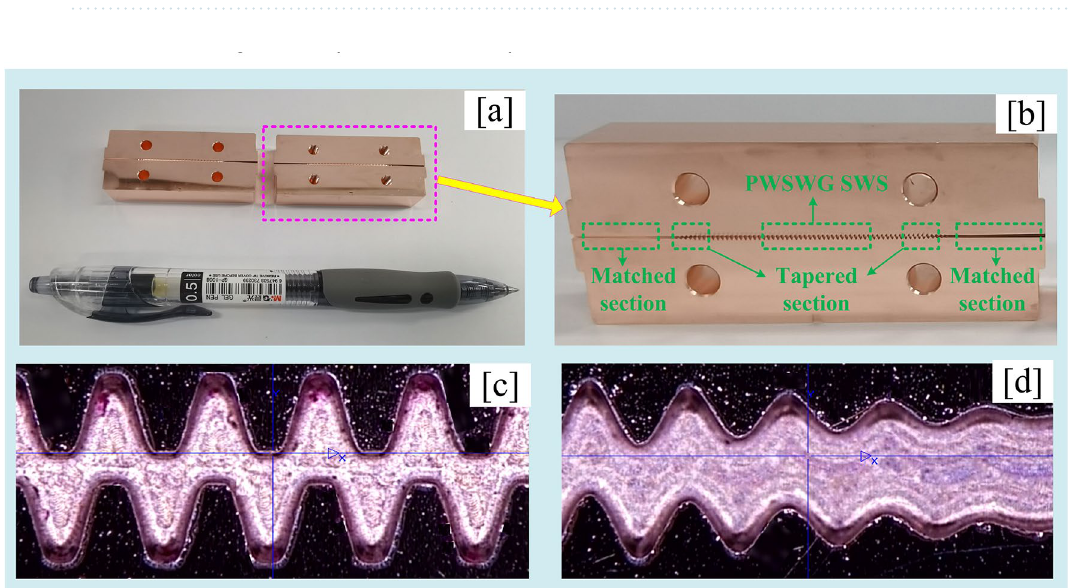
Figure 8. 3D model of the PWSWG interaction circuit in CST MWS. The inset illustrates the design of the connect section.